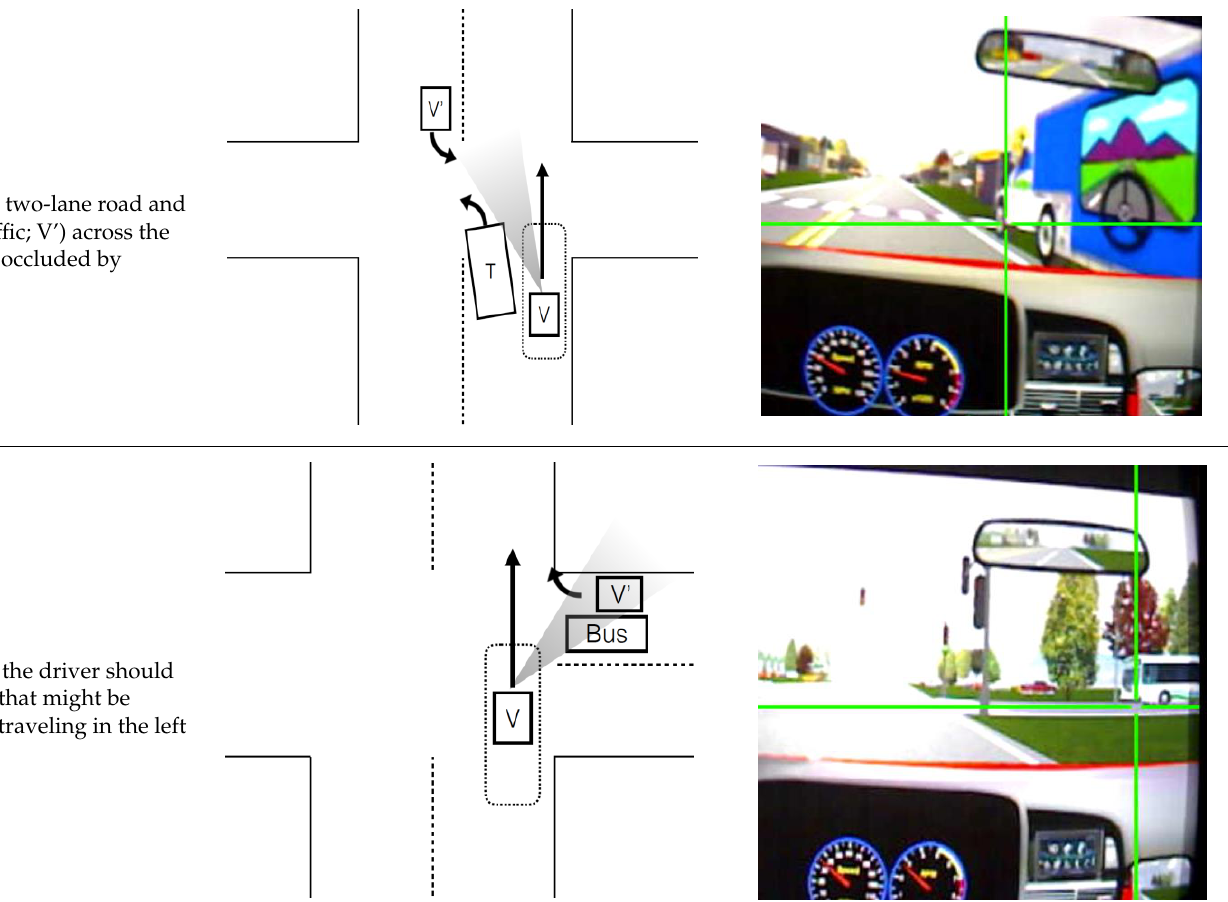
Table 1. In schematic representation of each scenario, the dotted square depicts the launch zone and the graded cone depicts the target zone. A perspective view with a crosshair indicating the location of a correct glance toward the target